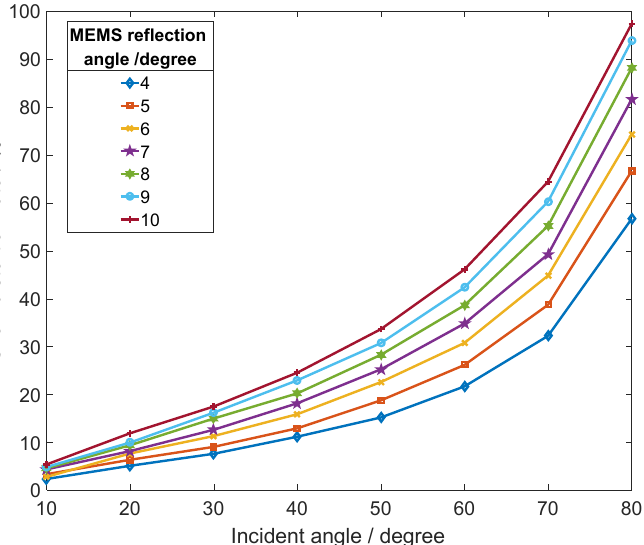
Figure 7. Skew distortion rates at different incidence angles and different deflection angles of MEMS micromirrors.